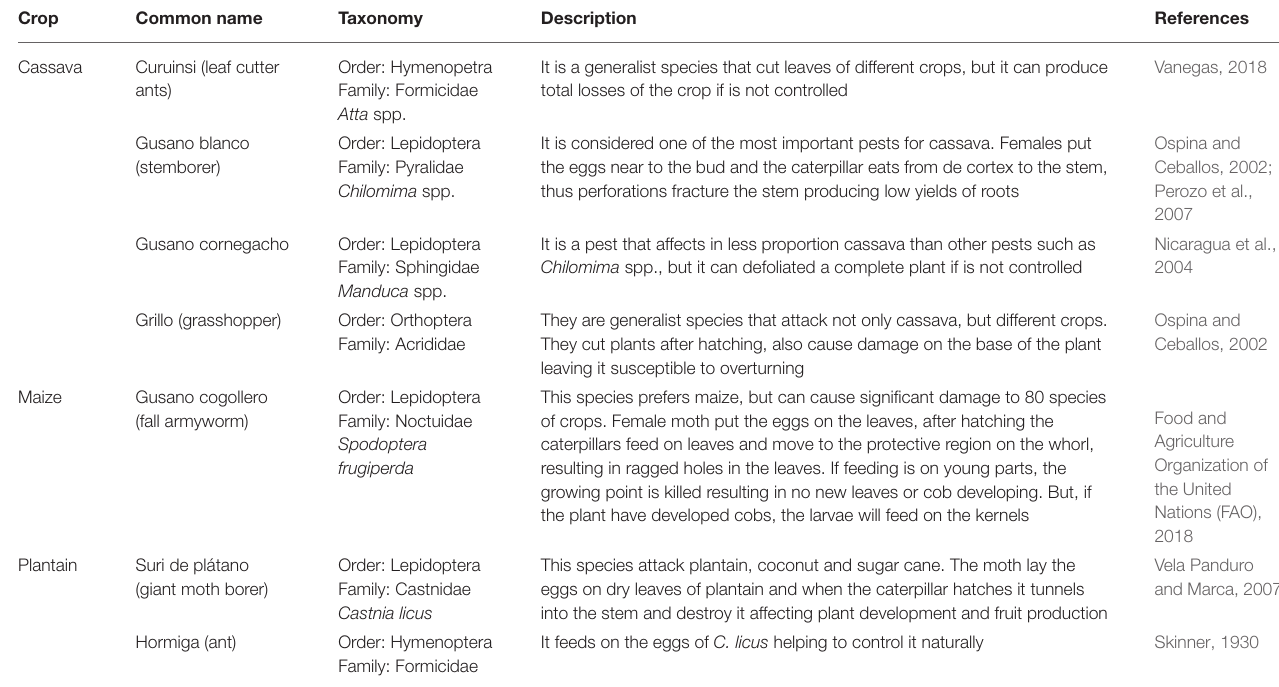
TABLE 3 | Etic description of the most salient insects identified by women and men based on the literature.